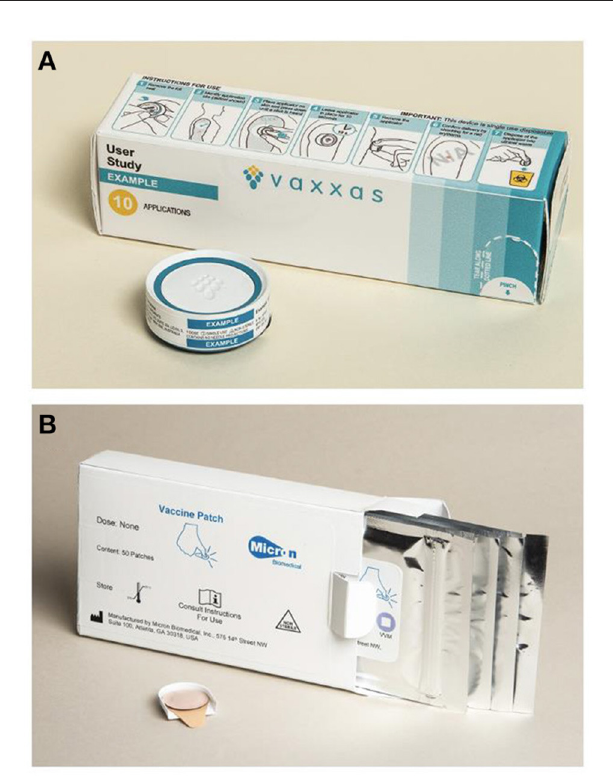
FIGURE1 Prototypes of MR-MAPs in development: Vaxxas (A) and Micron Biomedical (B) . MR-MAP, measles and rubella microarray patches. All images are shared with the companies’